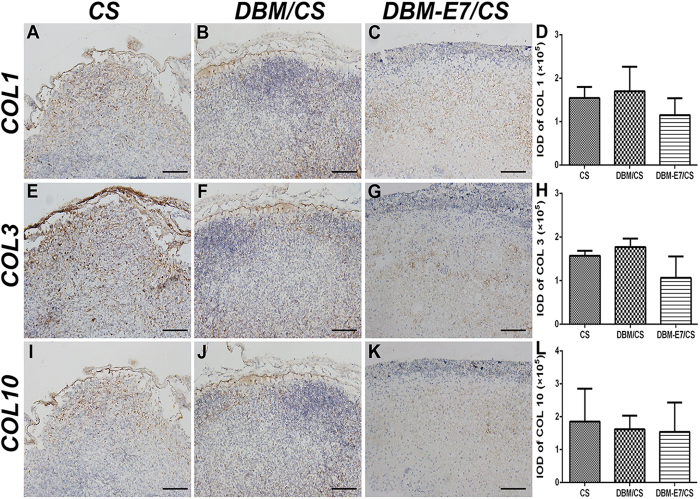
Osteogenesis, hypertrophic scarring, and hypertrophy assessment of the regenerated tissue.(A–D) COL1 production was evaluated for osteogenesis. (E–H) COL3 production was assessed for hypertrophic scarring. (I–L) COL10 was tested for hypertrophy of BMMSCs on different scaffolds by IHC staining. Bar = 100 μm, n = 5, p > 0.05.